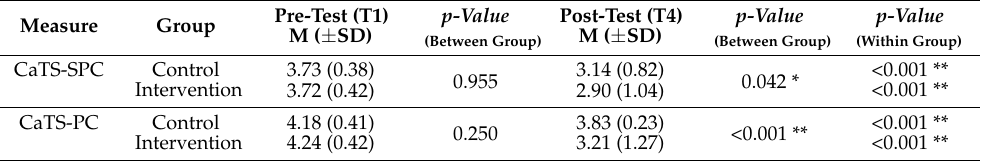
Table 4. Effect of SCEIP on CaTS between and within intervention and control groups across